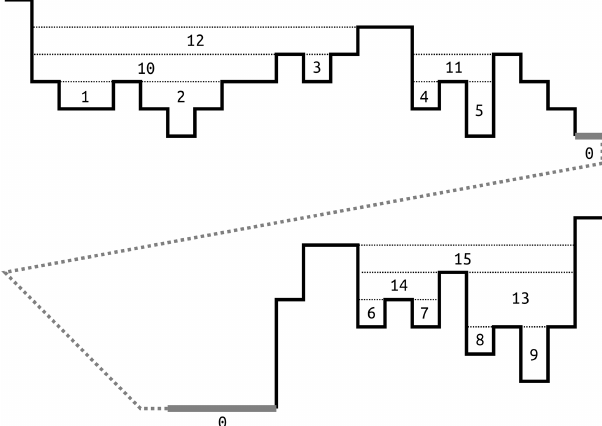
Figure 2. 1D topography representing the depression hierarchy pre- sented in Fig. 1. Solid black lines represent topography. The thick gray line represents the ocean, and the dotted line indicates that this figure represents a single continuous profile that has been split to better fit on the page. Following Fig. 1, numbers mark depres- sions and meta-depressions, and “0” marks the ocean. A traditional depression-filling flood-fill algorithm would simply fill each depres- sion up to the level of the highest dotted line, thus losing informa- tion on the structure within each